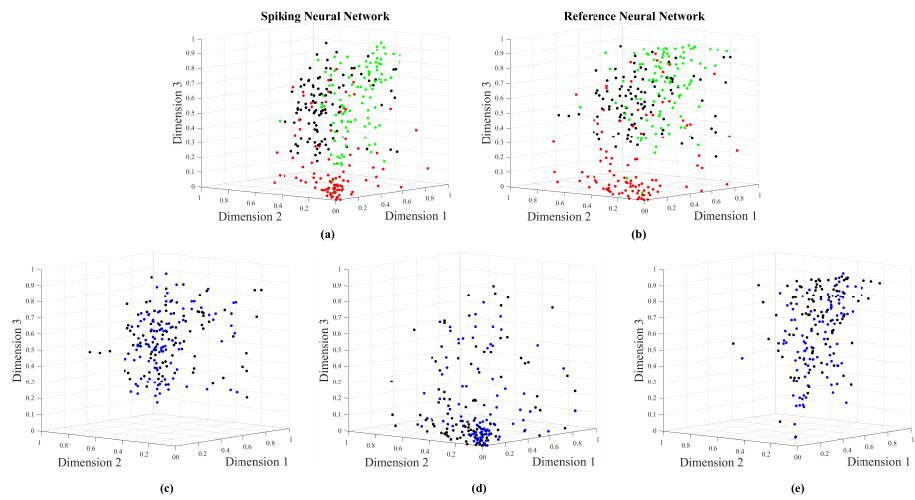
Figure 9. Class distribution for the Flowers, Fruits and Faces Database. In Figure 9a,b, each color represents a class. In Figure 9c–e the blue color corresponds to the SNN distribution and the black color to the reference continuous-sigmoid neural network distribution. ( a ) Distribution from SNN architecture. ( b ) Distribution from autoencoder. ( c ) Flowers class. ( d ) Fruit class. ( e ) Faces class.